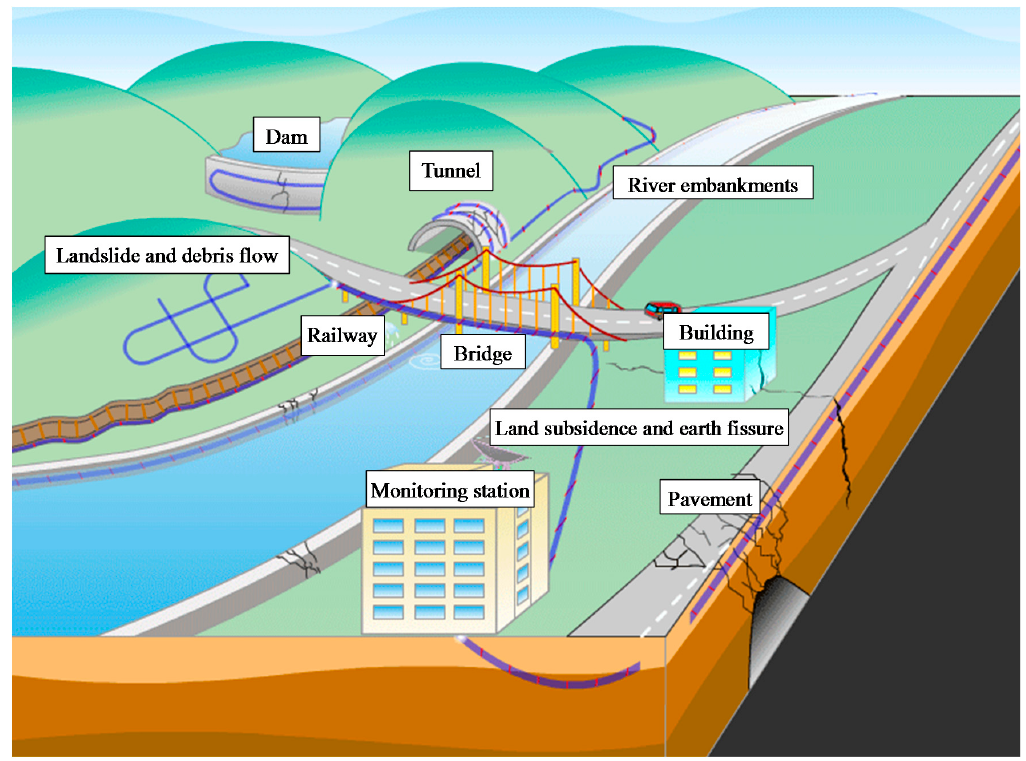
Figure 6. Schematic illustration of geohazards and infrastructure monitoring using FOS technologies.